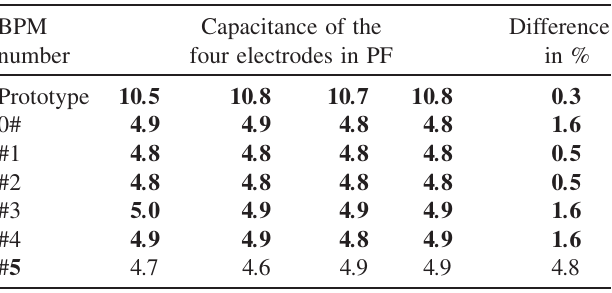
TABLE III. Measured capacitances of the electrodes. The measurement was performed from the SMA connector with a LC meter, 1.4 pF capacitance of the feedthrough itself has been deduced. Only small differences of the capacitance values mea- sured at the same BPM block were